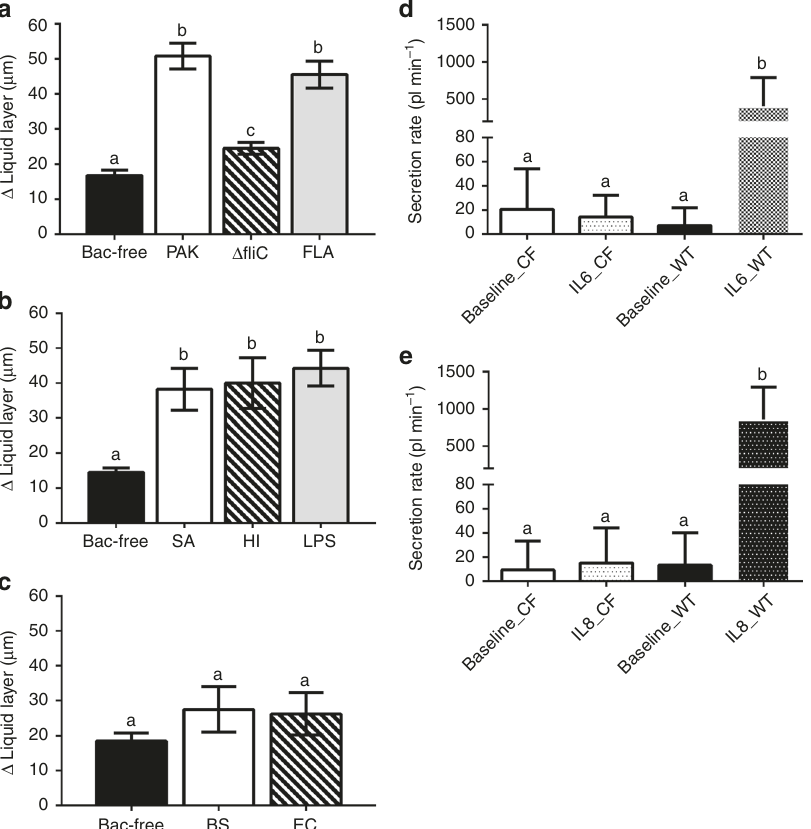
Fig. 3 Stimulation of pattern recognition receptors triggers ASL secretion in wild-type swine in vivo. a P. aeruginosa PAK strain-laden agarose beads (PAK) signi fi cantly stimulates ASL secretion. PAK Δ fl iC-laden agarose beads ( Δ fl iC), which lacks fl agellin, induce much less ASL secretion. Flagellin-laden (10 ng/ ml) agarose beads (FLA) triggered a similar response as PAK beads ( n = 11 bacteria-free from six pigs, n = 10 PAK from six pigs, n = 10 Δ fl iC from seven pigs, and n = 8 FLA from fi ve pigs; P < 0.0001, F (3, 35) = 36.59, ANOVA and Tukey ’ s multiple comparison test). b S. aureus- (SA), H. in fl uenza -laden (HI), and LPS (20 µ g/ml)-laden agarose beads stimulate ASL secretion in wild-type swine ( n = 10 bacteria-free from seven pigs, n = 7 S. aureus from four pigs, n = 7 H. in fl uenzae from four pigs, and n = 7 LPS from fi ve pigs; P = 0.0003, F (3, 27) = 8.79, ANOVA and Tukey ’ s multiple comparison test). c The non-pathogenic B. subtilis (BS) - and E. coli (EC)-laden agarose beads failed to trigger ASL secretion in wild-type swine ( n = 10 bacteria-free from six pigs, n = 7 E. coli DH5- α from fi ve pigs, and n = 7 B. subtilis from six pigs; P = 0.34, F (2, 21) = 0.40, ANOVA and Tukey ’ s multiple comparison test). Secretion assay data showed that d IL-6 (50 ng/ml, n = 16 preparations from seven CFTR − / − animals and n = 9 preparations from four wild-type animals, P < 0.0001, F (3, 60) = 12.79, ANOVA and Tukey ’ s multiple comparison test) and e IL-8 (50 ng/ml, n = 15 for CFTR − / − airway tissue from seven pigs and n = 10 for wild-type tissue from four pigs, P < 0.0001, F (3, 56) = 13.09, ANOVA and Tukey ’ s multiple comparison test) both trigger submucosal gland secretion in wild-type airway, but fail to stimulated ASL secretion in CF airway. Data is presented as mean ± SEM and within each panel the columns labeled